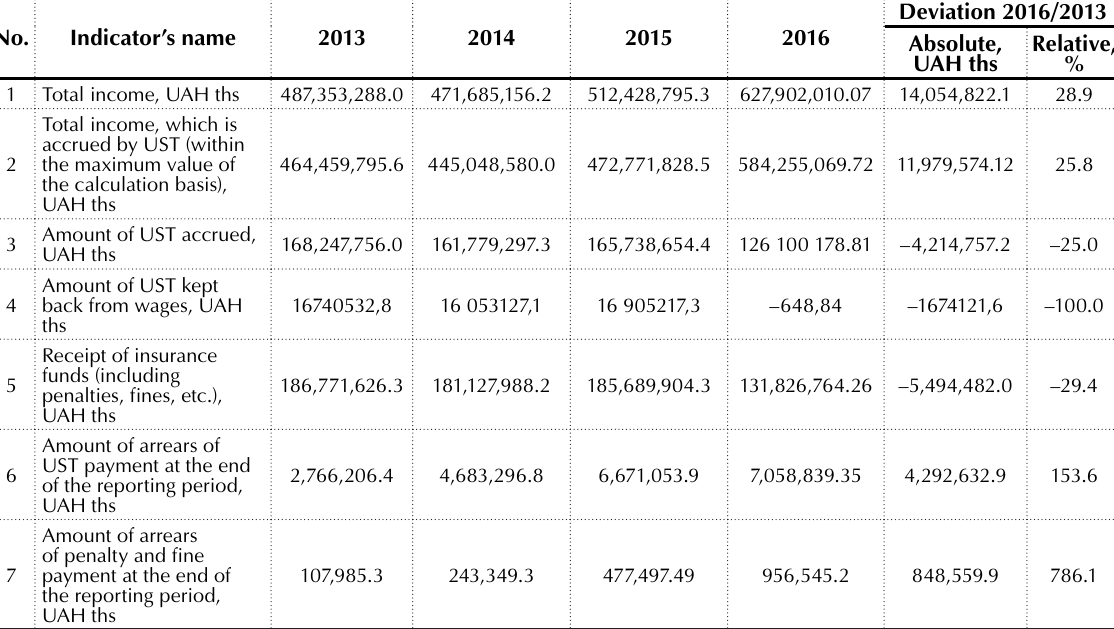
Table 1. Dynamics of UST indicators for compulsory state social insurance during